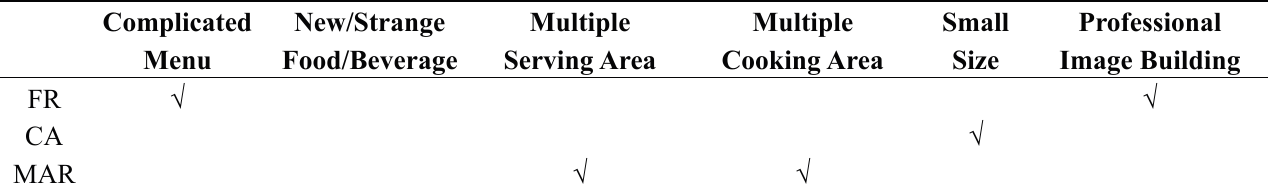
Table 4. The purposes of using